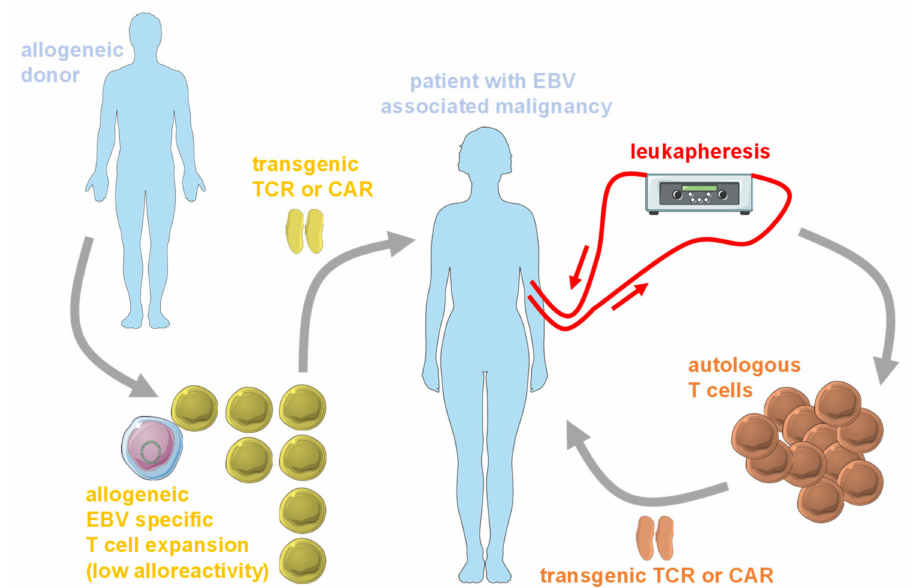
Figure 3. In addition to autologous T cells that can be obtained from leukapheresis of the peripheral blood of patients with EBV associated malignancies at su ffi cient numbers for TCR or chimeric antigen receptors (CAR) transgenic T cell therapies, allogeneic T cells can be used, but their alloreactivity against the recipient needs to be limited. EBV specific T cells that can be expanded from allogeneic T cells have been found to carry only low alloreactivity and are used for clinical trials with CAR transgenic T